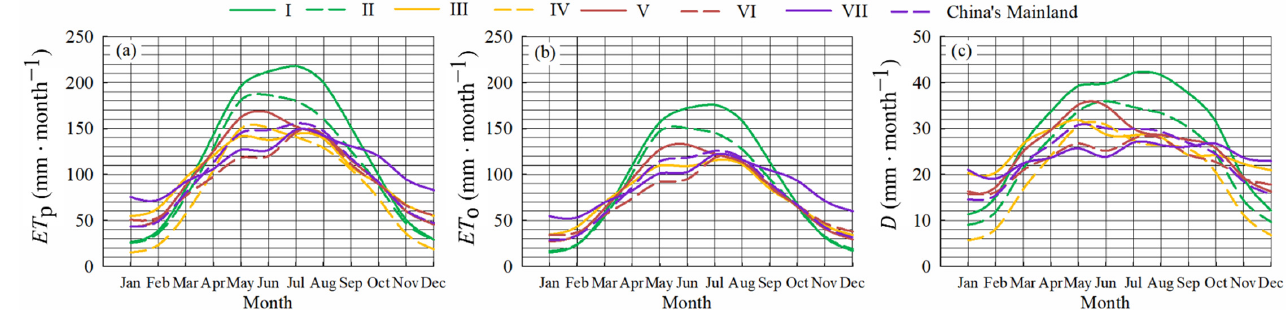
Figure 5. The long-term mean monthly variables averaged from the sites of different sub-regions. ( a ) ET o , ( b ) ET p and ( c ) D .